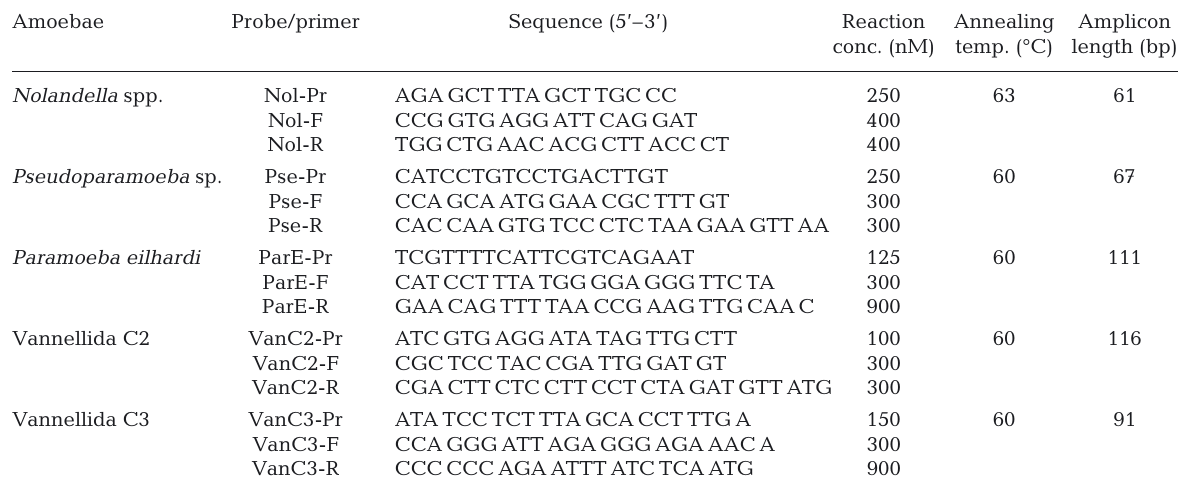
Table 2. Probe (Pr) and primer (F: forward; R: reverse) sequences and assay parameters for detecting various amoeba